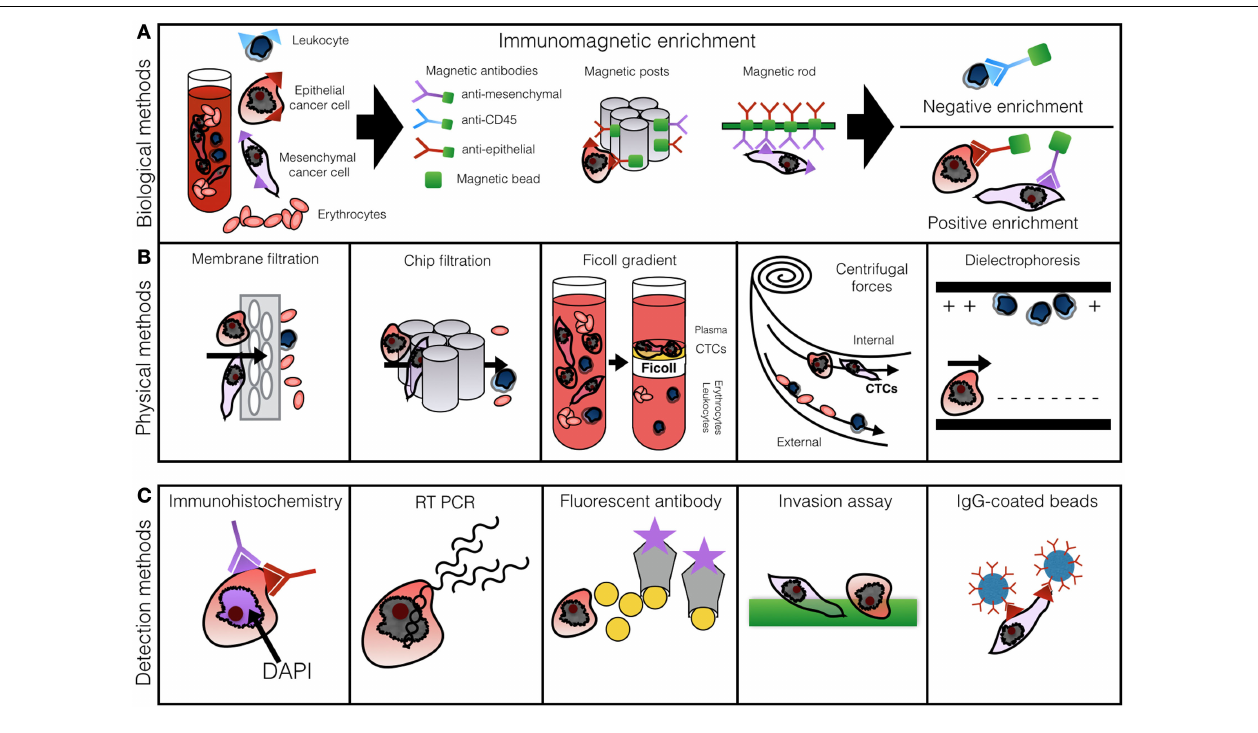
centrifugation, Dean drag forces separation, and dielectrophoresis. Row (C) outlines the most common principles of cell enumeration: IHC, RT-PCR, fluorescent antibody labeling, invasion assay, or antibody-coated beads. Based on Alix-Panabieres and Pantel (46) with permission.